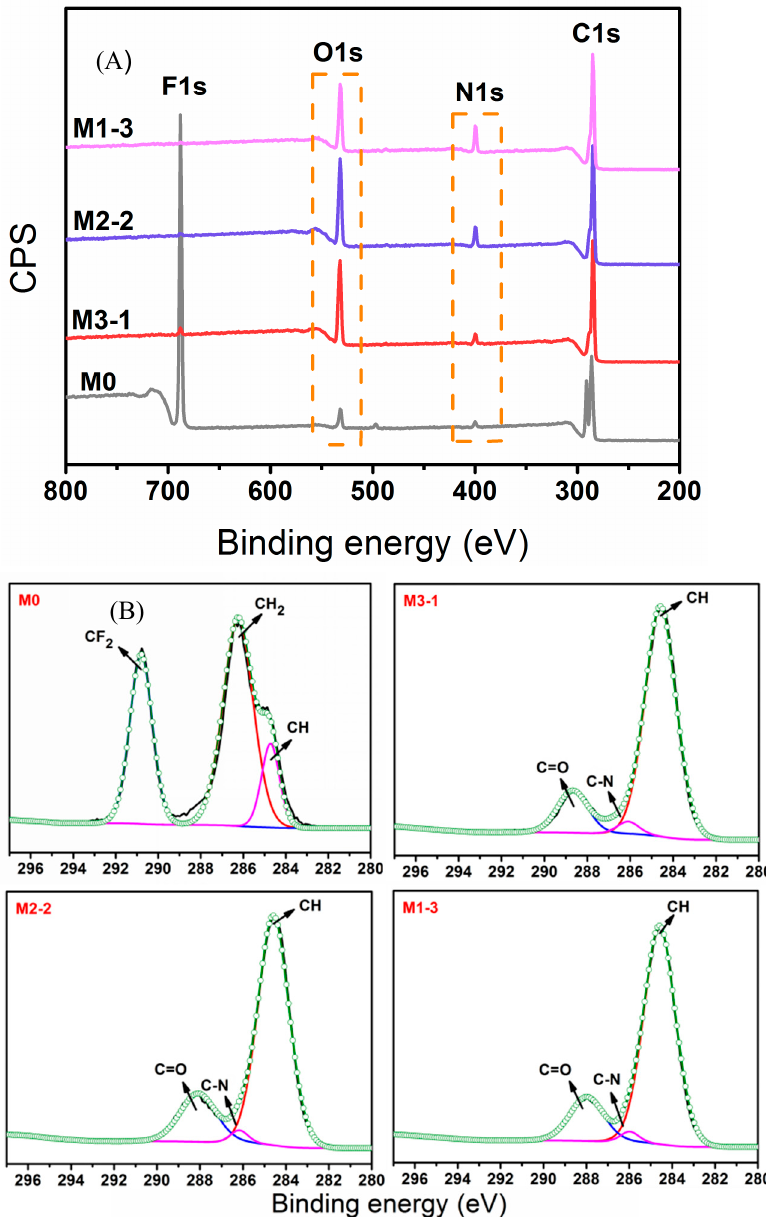
Figure 3. ( A ) X-ray photoelectron spectroscopy (XPS) spectra of membranes and ( B ) C 1 s core-level XPS spectra of membranes.